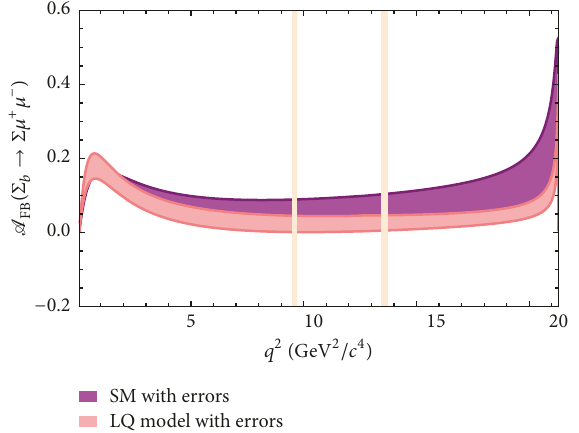
Figure 12: The dependence of A FB on 𝑞 2 for the Ξ 𝑏 → Ξ𝜏 + 𝜏 − transition in the SM and LQ models. The vertical shaded band indicates the charmonia veto